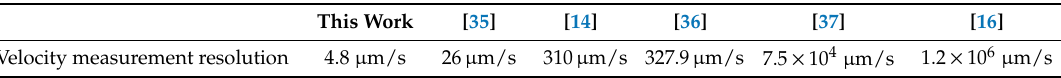
Table 2. Comparison between our DFDL system and existing dual-frequency